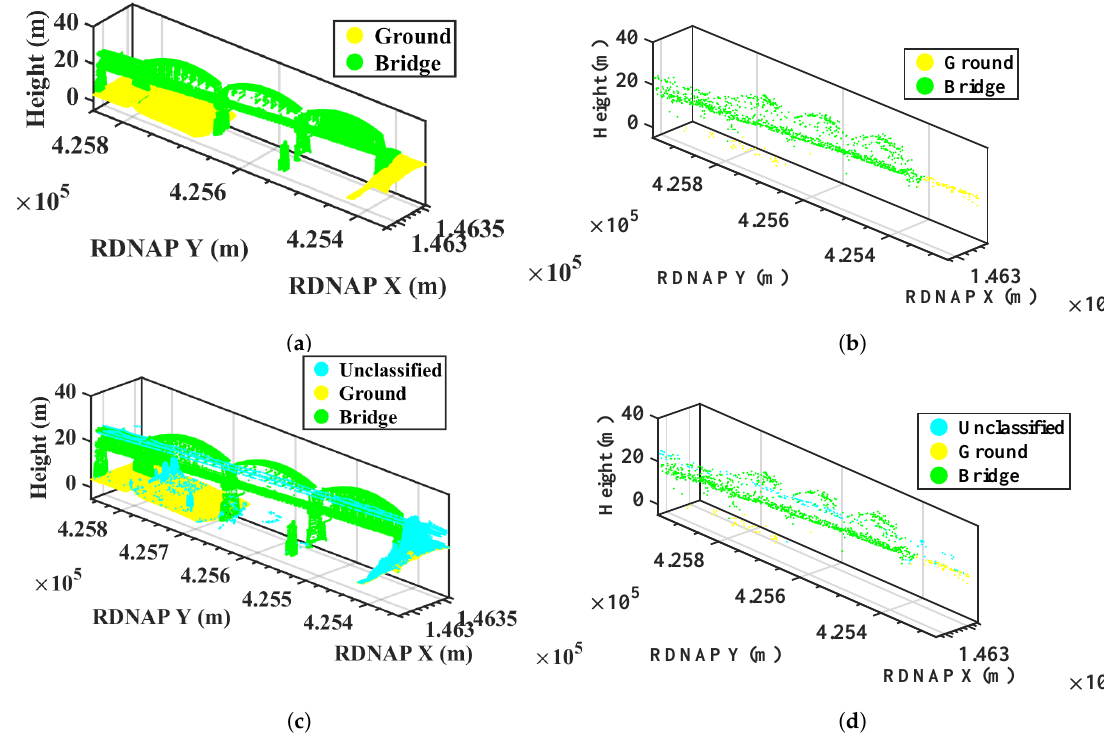
Figure 14. Comparison of classification map: ( a , c ) classification maps of LiDAR; ( b , d ) classification maps of radar scatterers; ( a , b ) classification maps without unclassified one; and ( c , d ) classification maps with unclassified